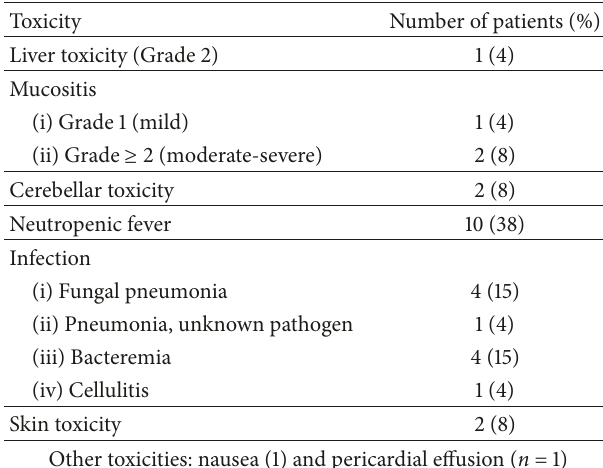
Table 3: Nonhematological adverse events. Toxicity Number of patients